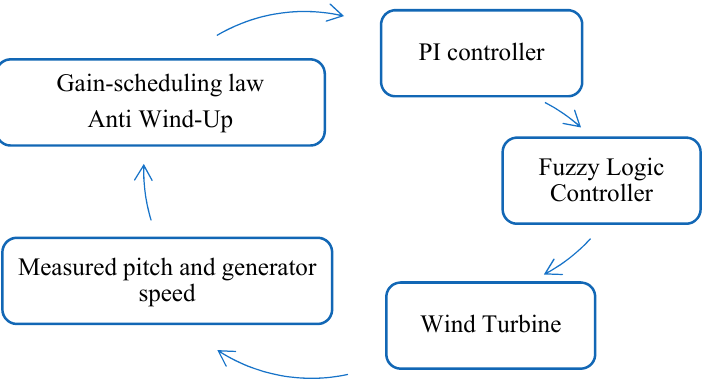
Figure 5. Simplified diagram for the proposed fuzzy logic controller topology scheme.